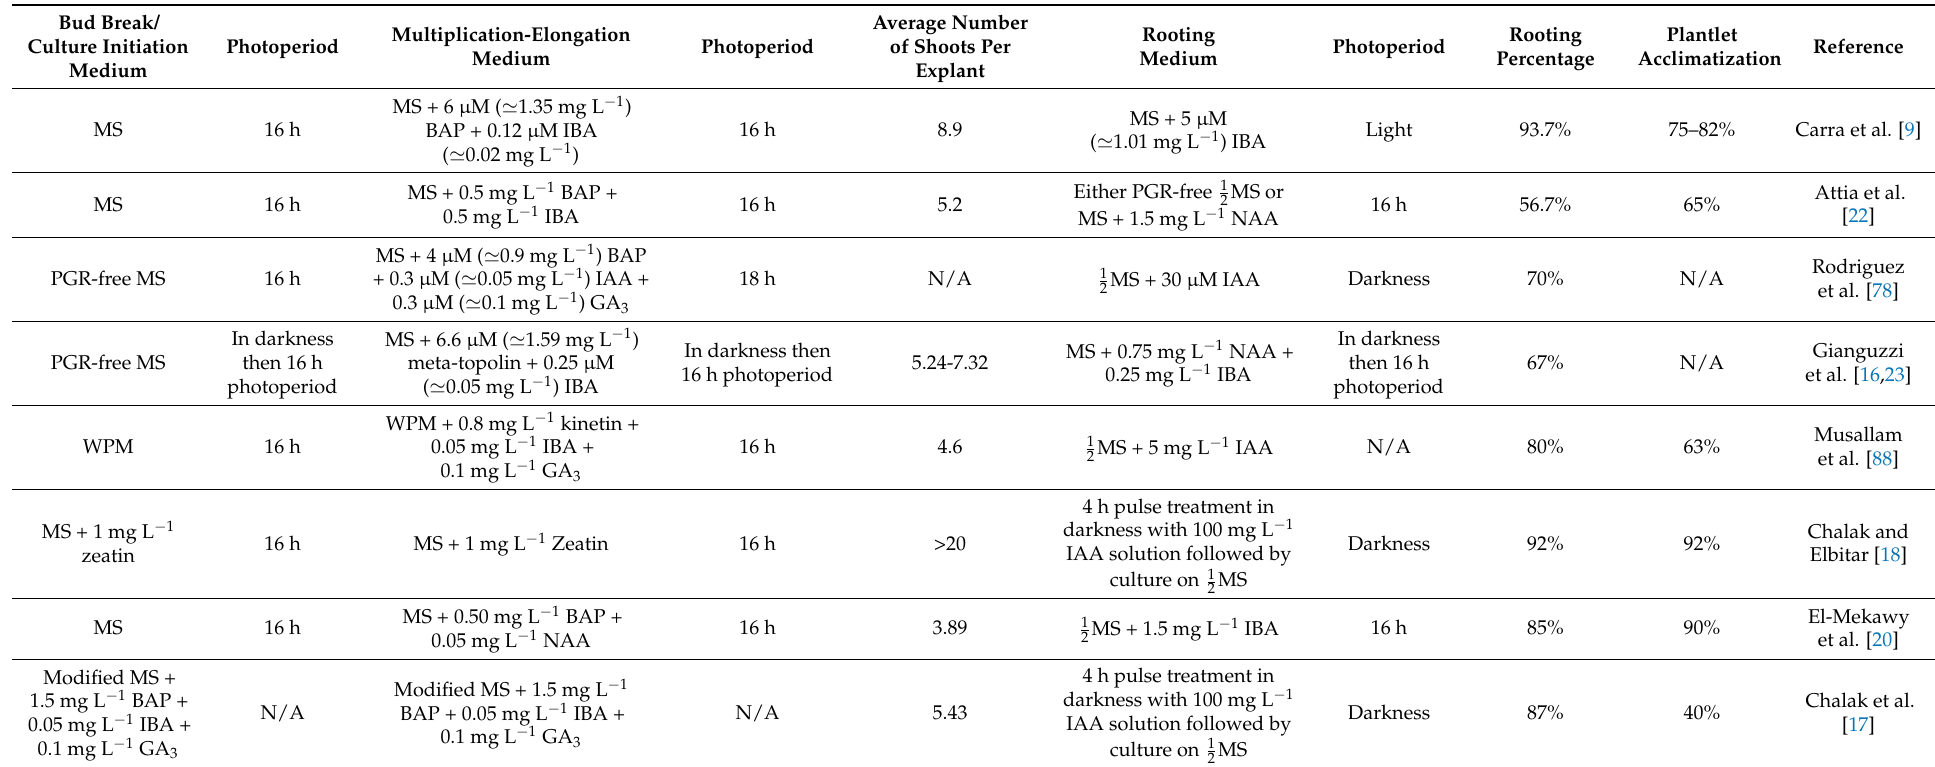
Table 2. Caper ( Capparis spinosa L.) propagation by